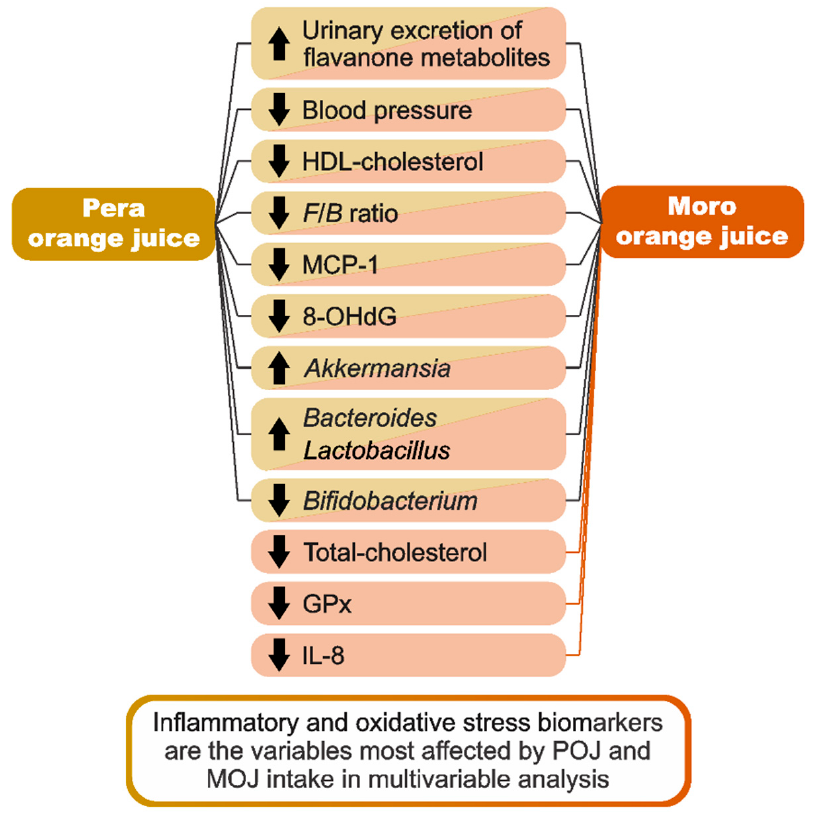
Figure 5. Schematic summary of the main findings of the study.